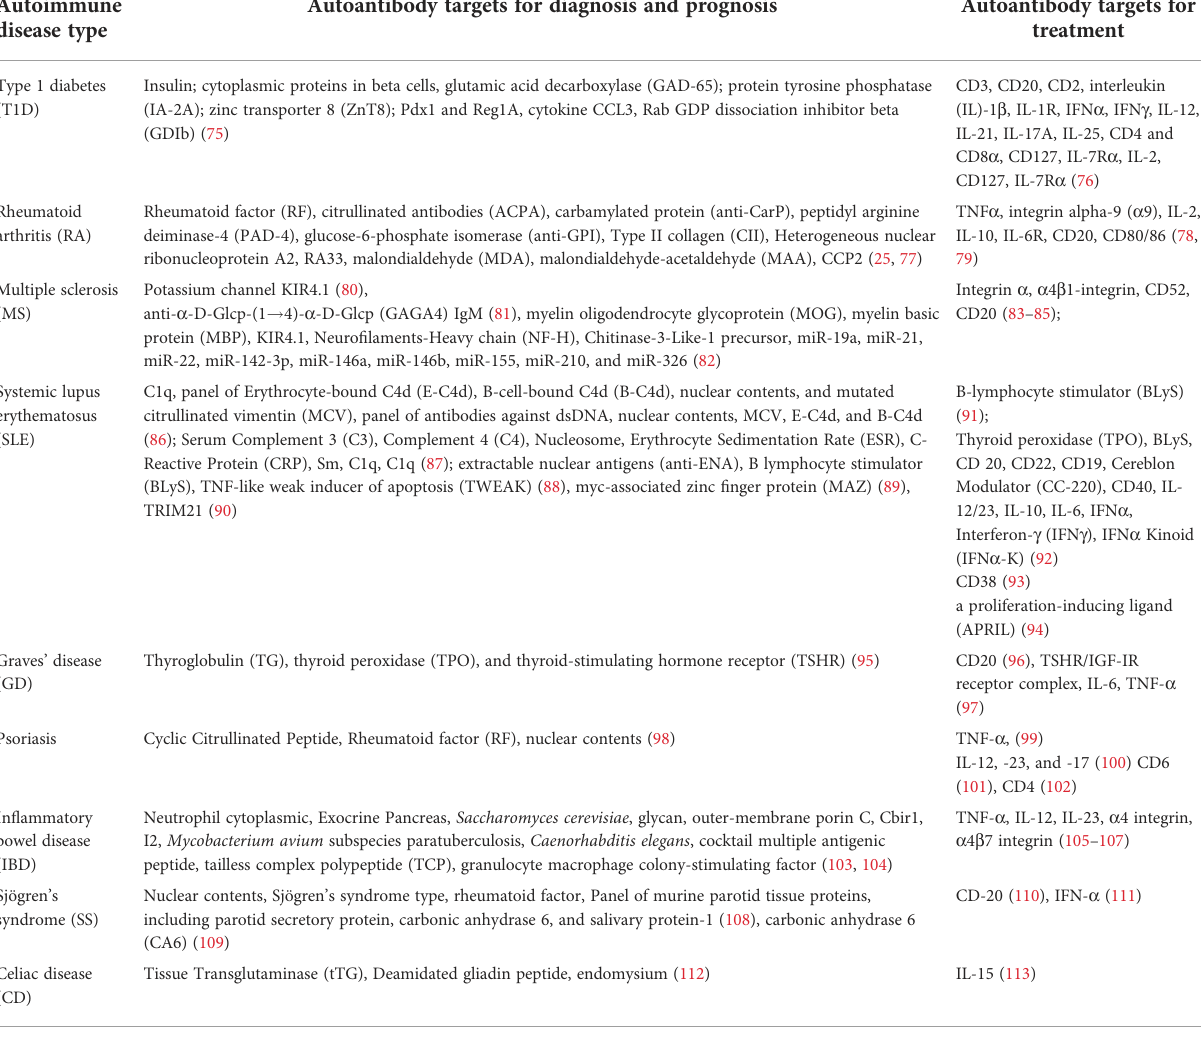
TABLE 1 Summary of autoantibody applications in various autoimmune disease. Autoimmune Autoantibody targets for diagnosis and prognosis Autoantibody targets for disease type